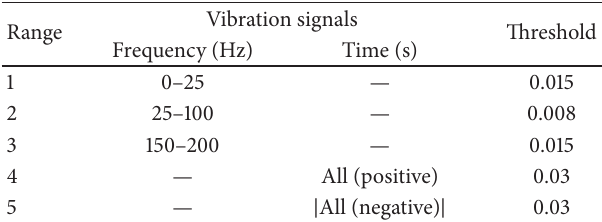
Table 2: Subranges and thresholds for the neural-expert